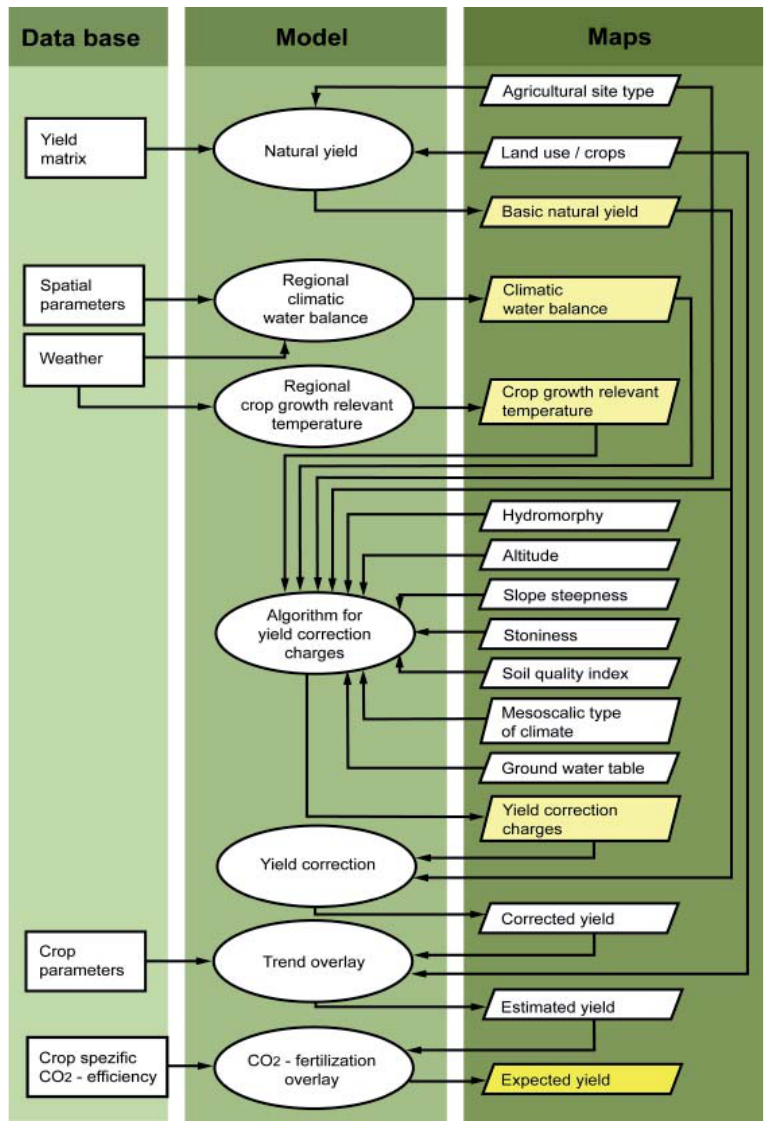
Figure 5. Implementation scheme of the crop yield estimation algo- rithm YIELDSTAT into the Spatial Analysis and Modelling Tool